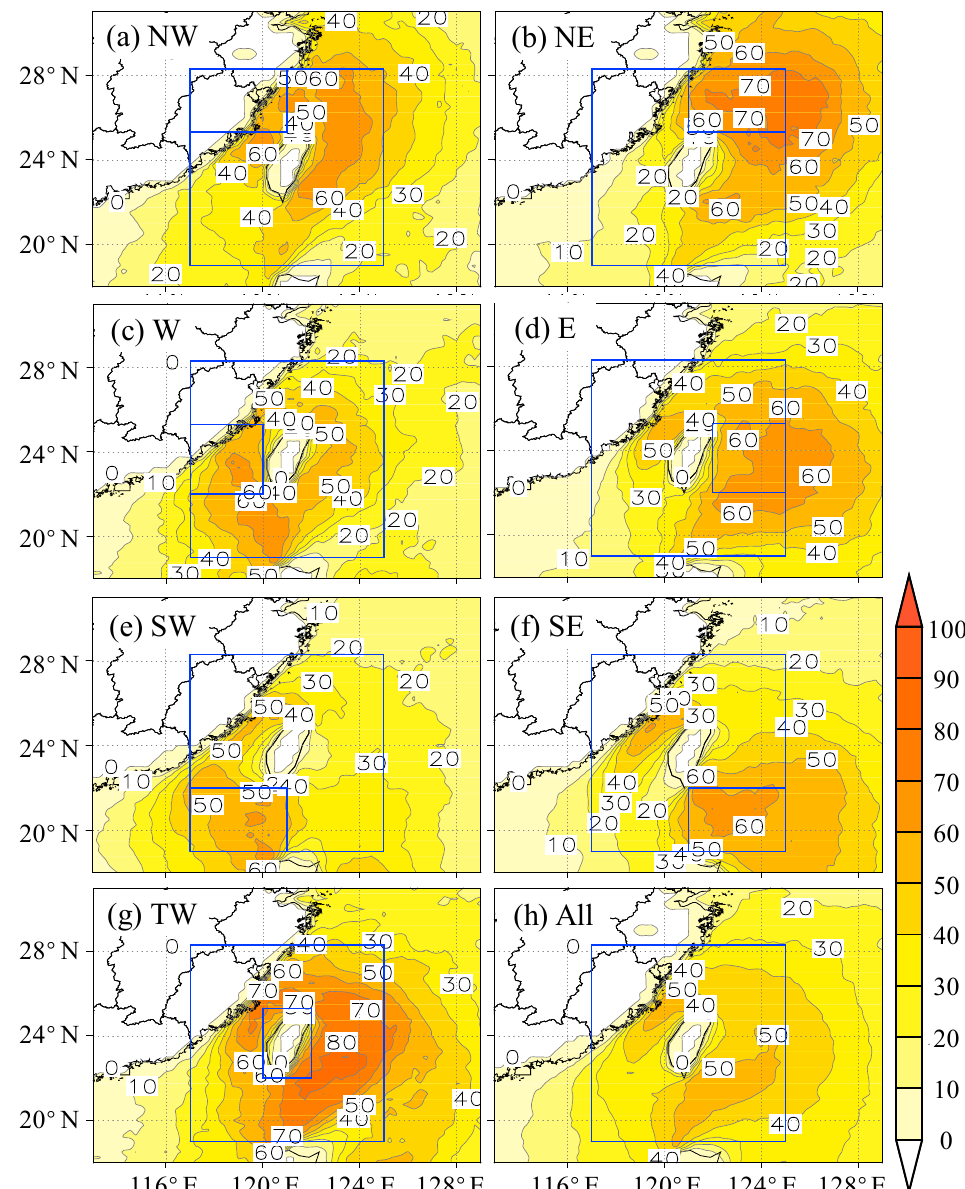
Figure 4. Percentage of the occurrence frequency of strong wind at 10-m height for wind speed exceeding 10 m s − 1 in ( a – g ) subregions and ( h ) all samples (All).